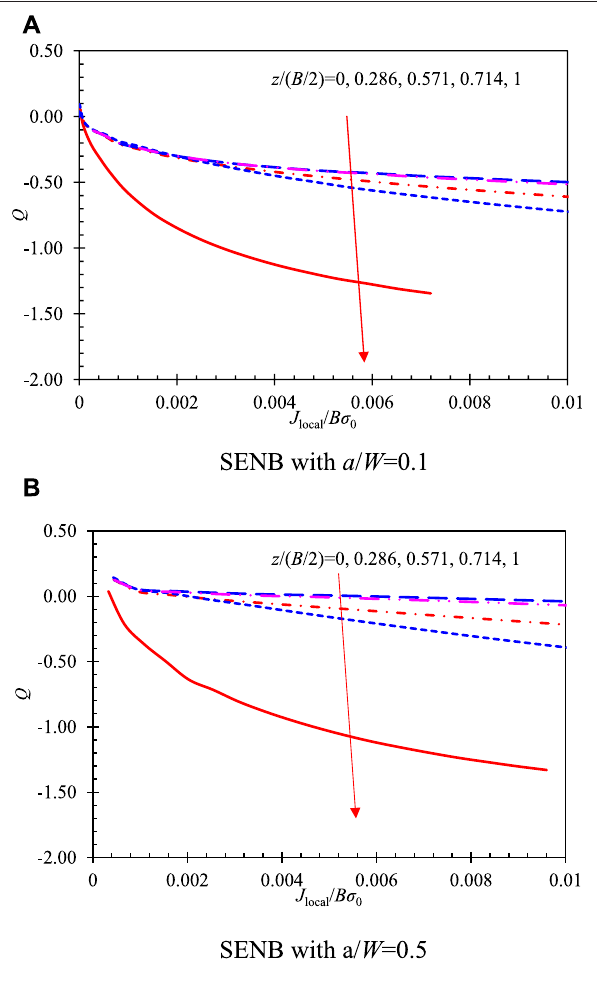
FIGURE6| Variationin Q withincreasedloadingoverthecrackfront. (A) SENB with a / W (cid:1) 0 . 1. (B) SENB with a / W (cid:1) 0 .